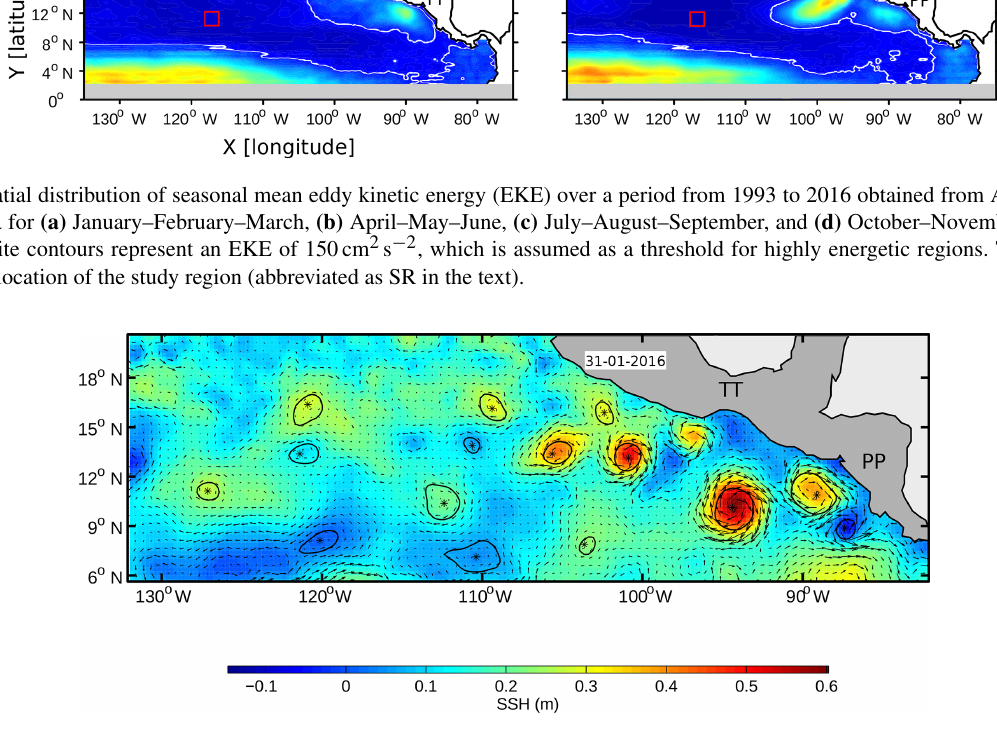
Figure 2. An example for applying the eddy detection algorithm on sea surface height altimetry data for 31 January 2016. Detected eddies are shown as closed black contours. The associated geostrophic field is shown by the black arrows. Cyclonic and anticyclonic eddies can be identified as differences in direction of water mass rotations. Centers of eddies are indicated as the black stars for each individual vortex. The amplitude of sea surface height is